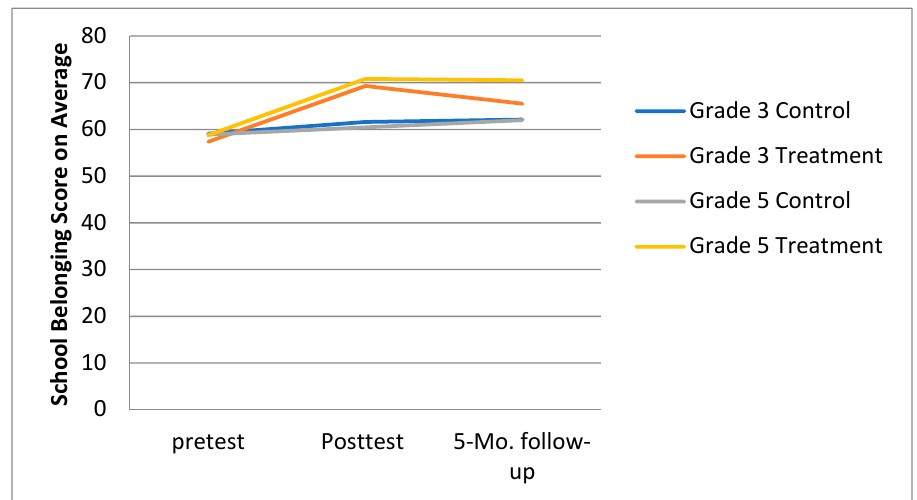
Figure 3. Comparison of sense of school belonging scores at three time points for third- and fifth grade students.